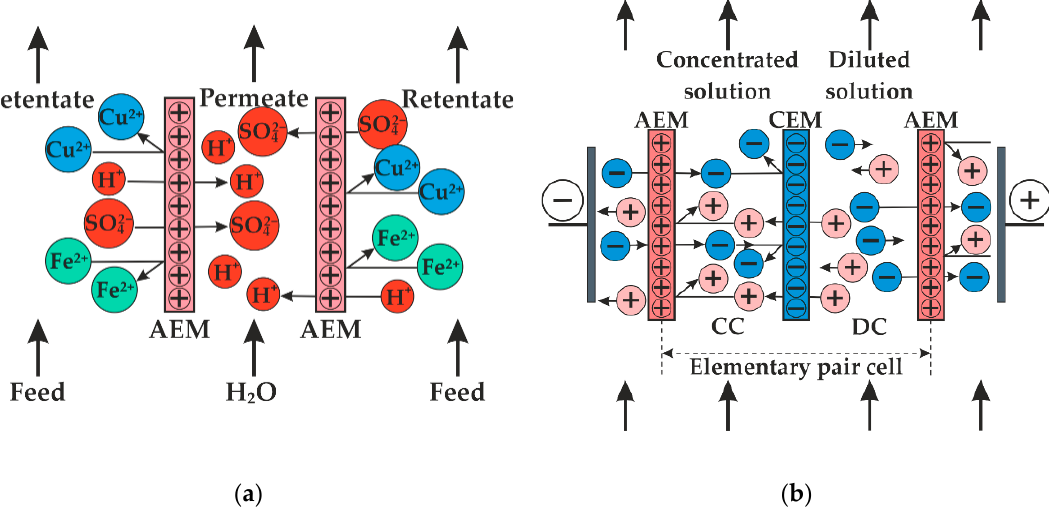
Figure 1. Scheme of ion fluxes in the diffusion dialysis ( a ) and electrodialysis ( b ) processes. Where DC is the desalination chamber and CC is the concentration chamber.